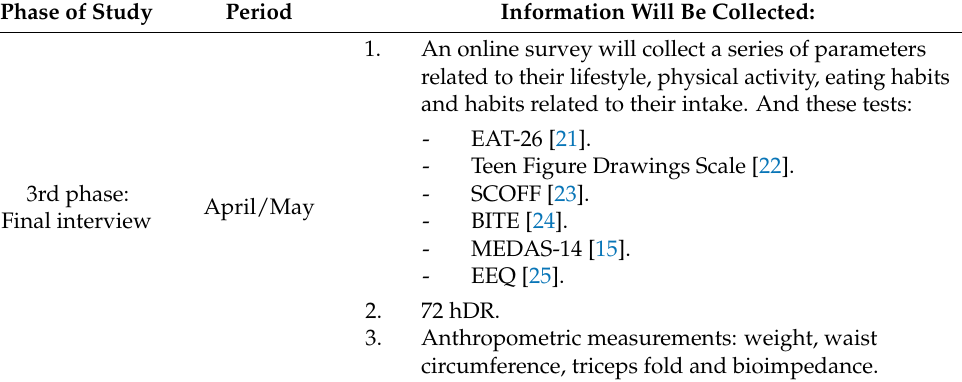
Table 2. Inclusion and exclusion criteria.